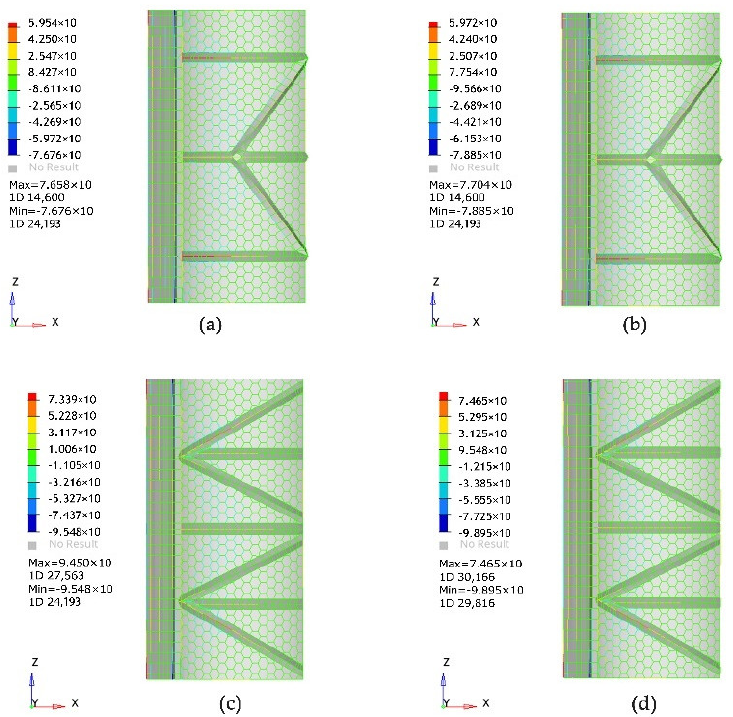
Figure 21. ( a ) Linear stress analysis of the carport I model under the G K load; ( b ) Nonlinear stress analysis of the carport I model under the G K load; ( c ) Linear stress analysis of the carport II model under the G K load; ( d ) Nonlinear stress analysis of the carport II model under the G K load.